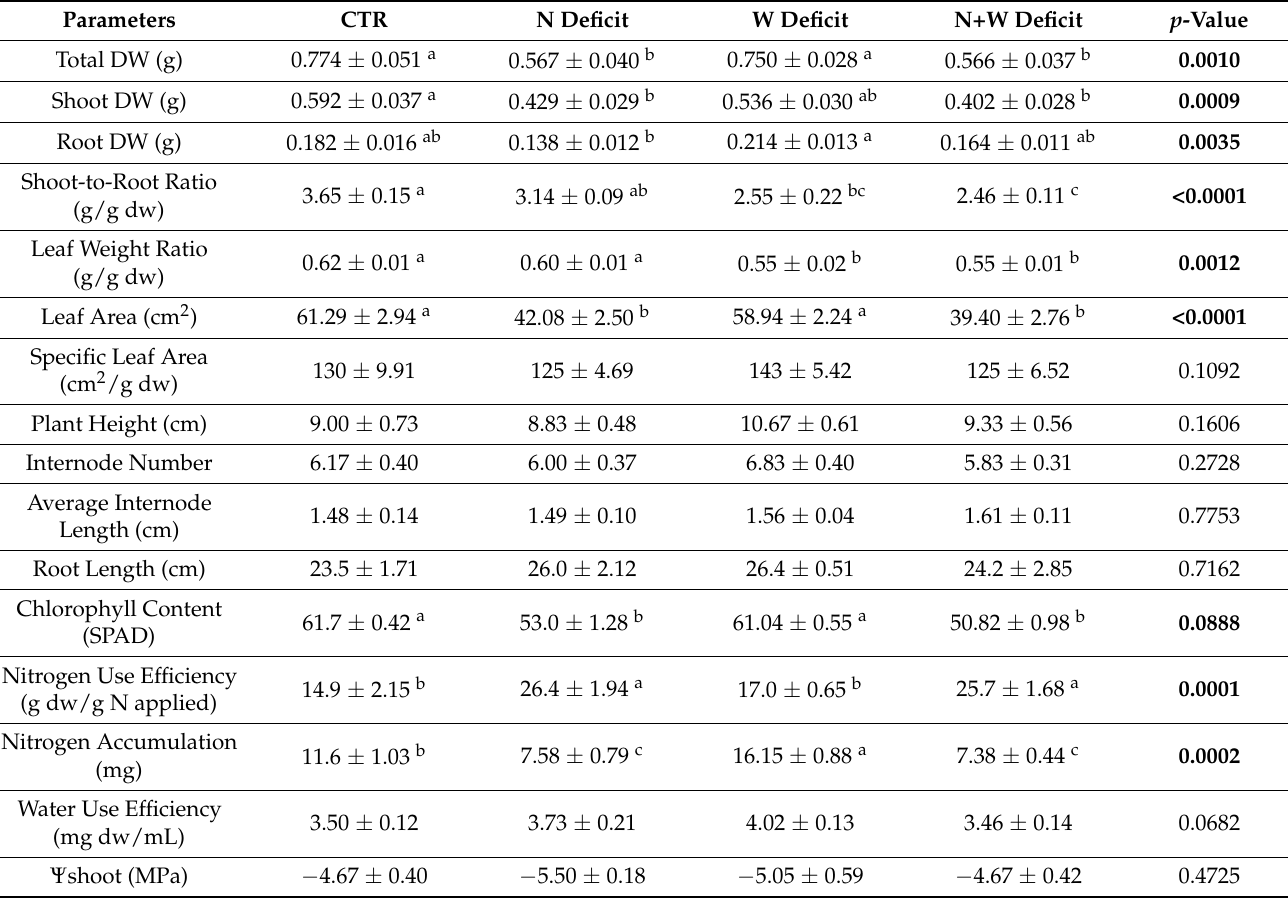
Table 1. Morphophysiological responses of tomato cv. Micro-Tom grown for 16 days under control (CTR; 10.5 mM N + 100% W), nitrogen deficit (N; 5.3 mM N + 100% W), water deficit (W; 10.5 mM